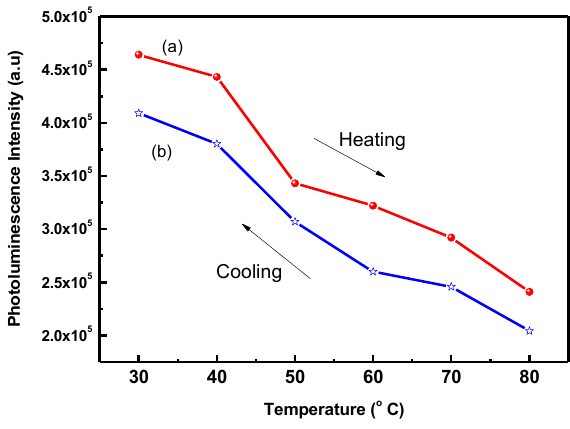
Figure 3. Photoluminescence intensity of POF 10 – b– PDPAEMA 90 in water at a heating–cooling cycle between 30 and 80 °C: ( a ) heating ( b ) cooling.